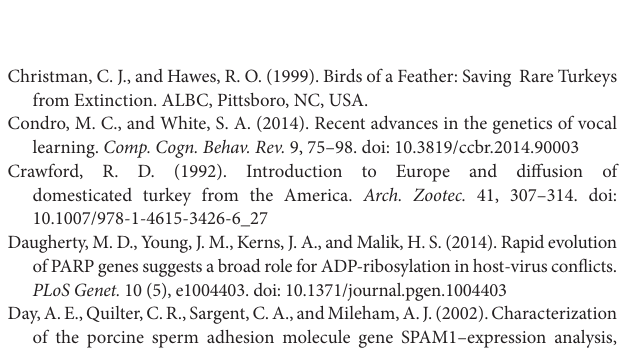
sUPPleMeNTARY TABle s6 | Annotation of all genes mapping within the